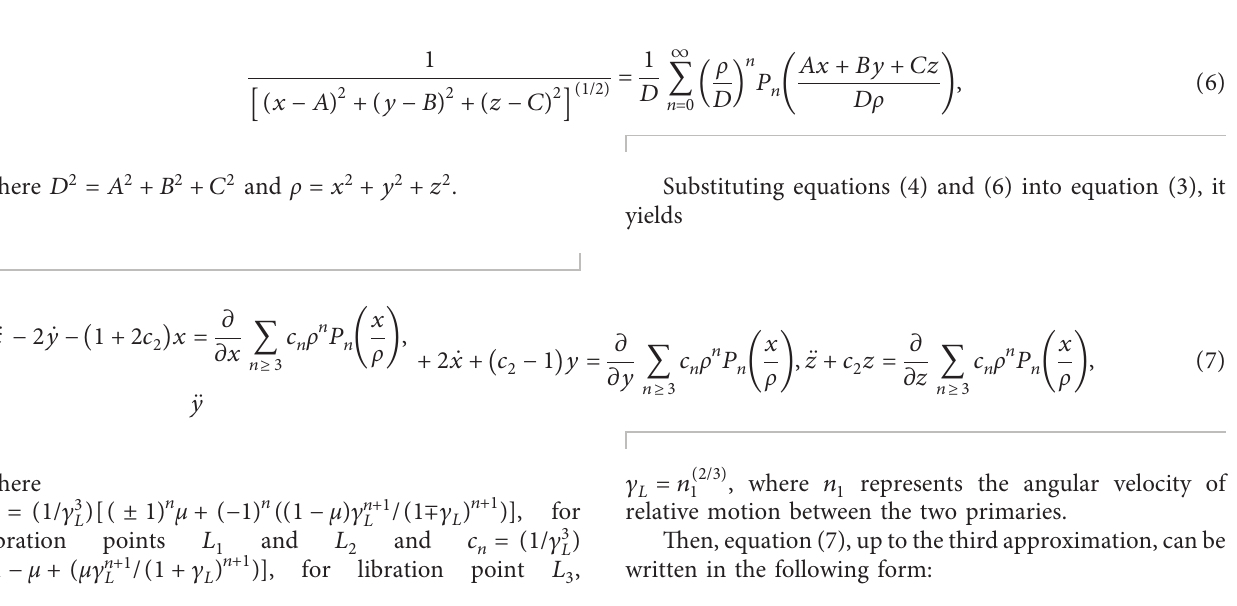
Figure 1: (a–c) Bifurcation diagrams of mass ratio parameters in µ-x-y , µ-x-z , and µ-y-z frames,